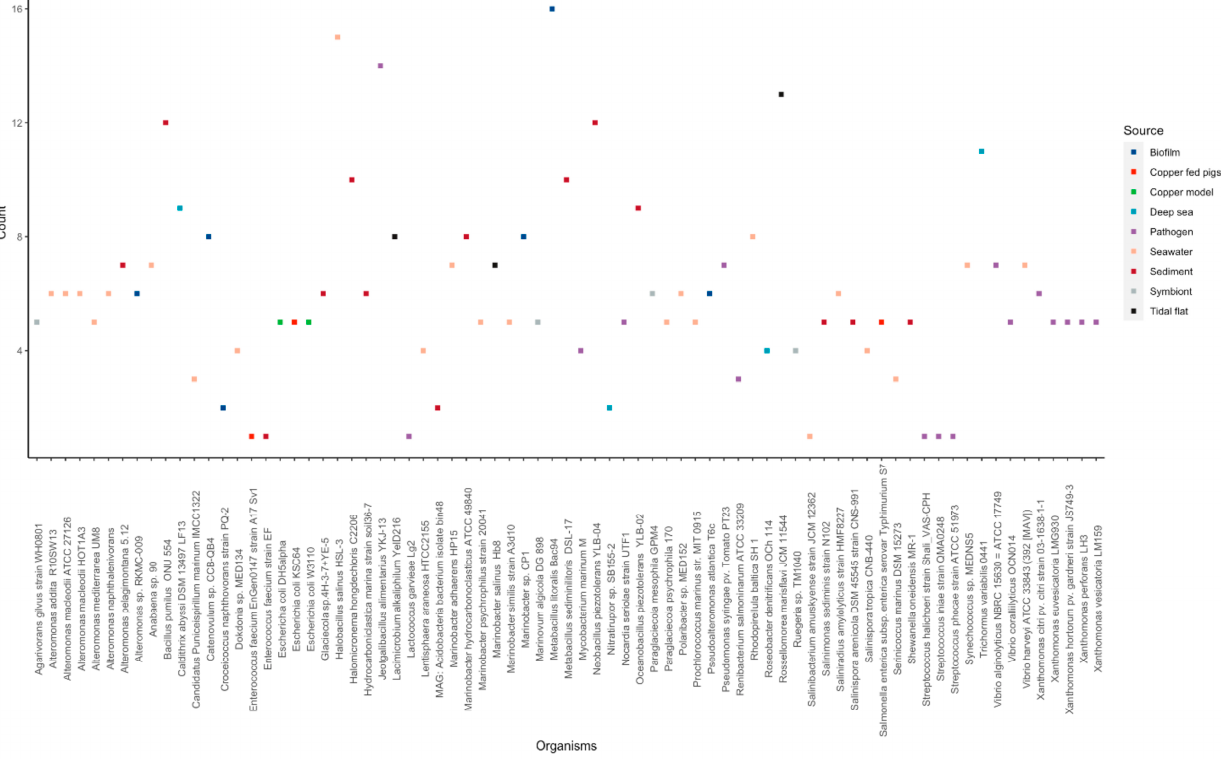
Figure 6. Distribution of the homolog hit count for the CorE system across marine bacteria. Each dot represents the total putative CorE hits for a specific bacterium. The dot colors depict the source of isolation shown in the panel on the left.